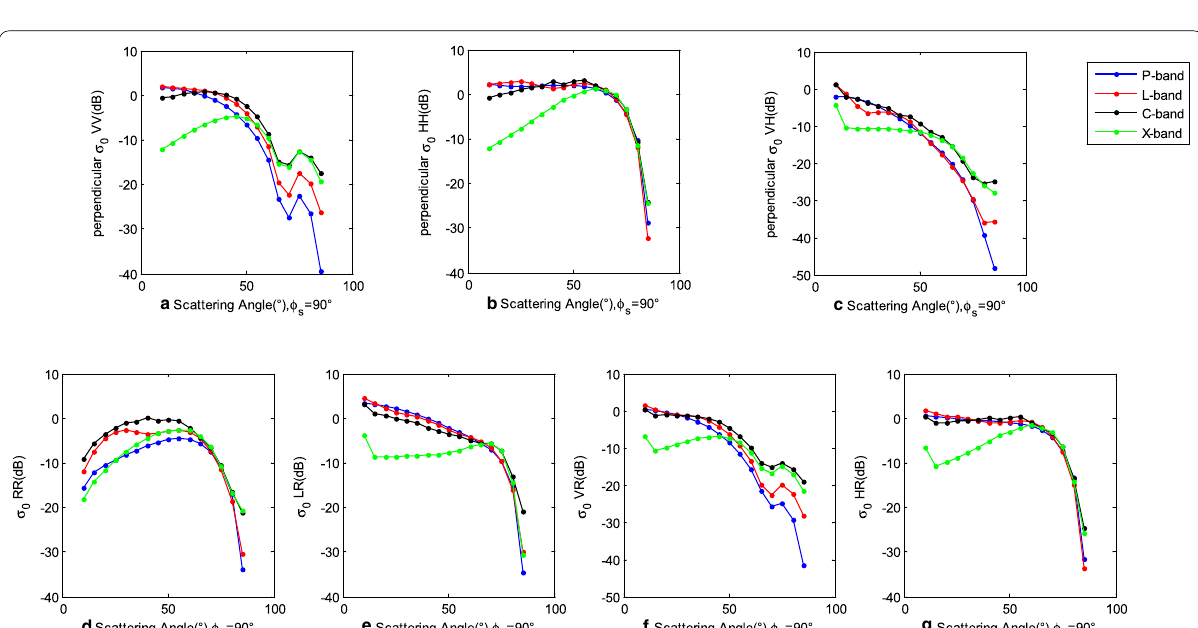
Fig. 11 Canopy scattering cross section versus scattering angle from aspen for L-, C-, and X-bands at perpendicular